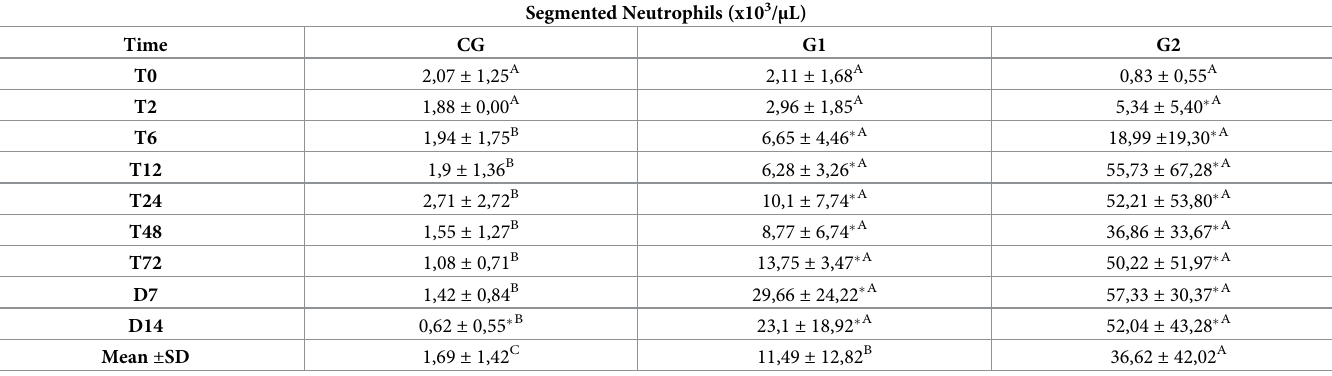
( � ) represent differences compared to baseline time (T0) within the group; Different capital letters represent differences between groups at the same time; p �